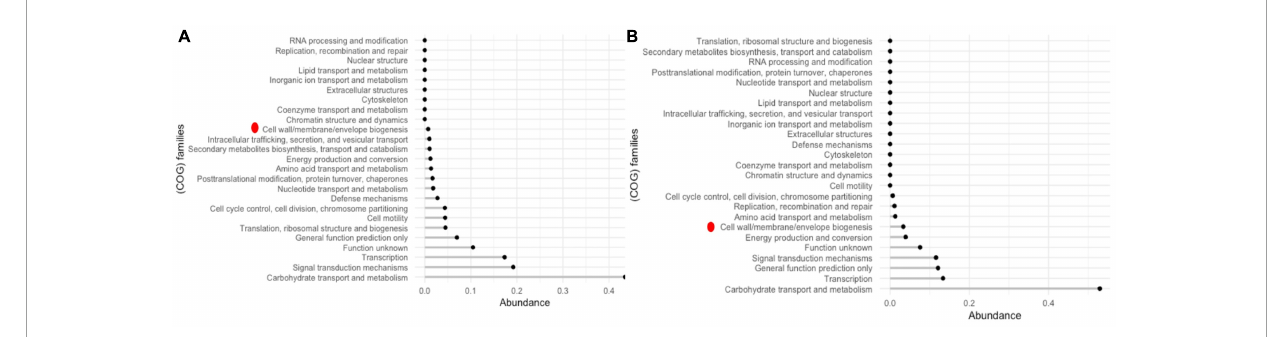
FIGURE5 COG families of accessory proteins (A) general E. faecium probiotic strains – T110, 170M39, and SP15LR13 and (B) cholesterol-lowering E. faecium probiotic strains LR 13 and WEFA23. Red dot represents the cell wall/membrane/envelope biogenesis COG family proteins which exhibited a fourfold abundance in LR13 and